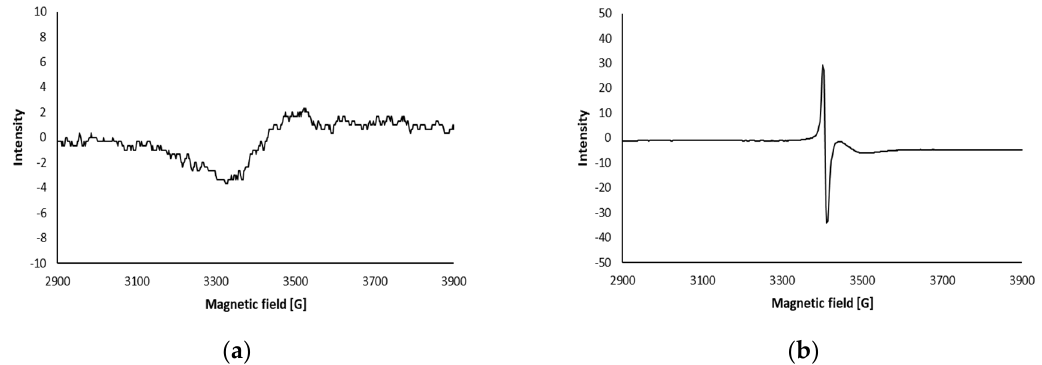
Figure 3. ESR spectra of tap WST after 30 ( a ) and 60 ( b ) min treatment.